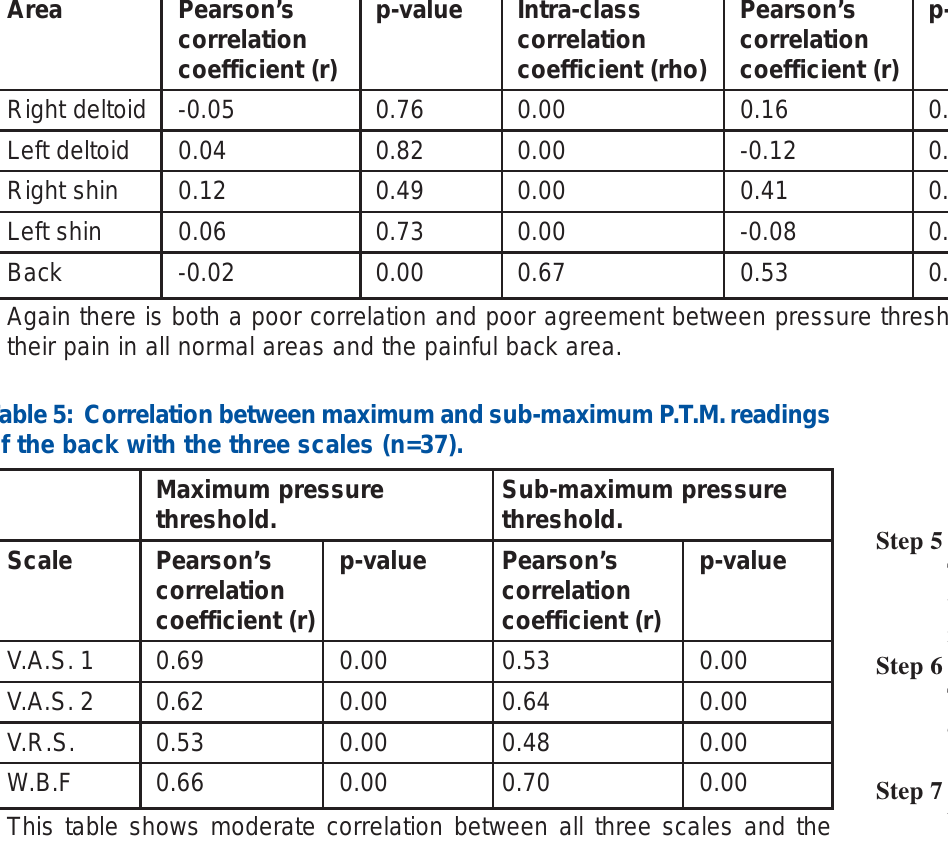
Table 4: Maximum and sub-maximum pressure threshold readings correlated with the V.A.S. 1 (n = 37). Maximum pressure